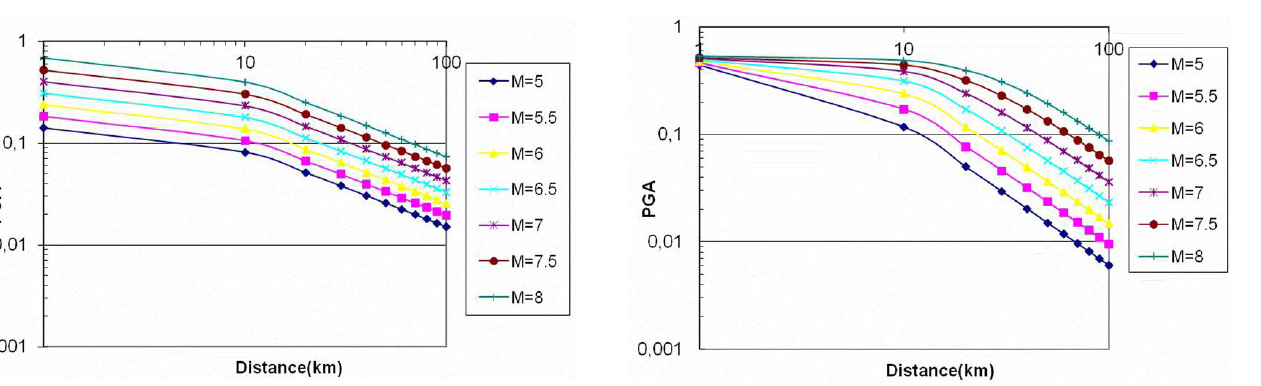
Fig. 8. The acceleration–distance relationship which is given vari- ous magnitude values according to Campbell (1997). Table 2. Recommended values for the average shear wave